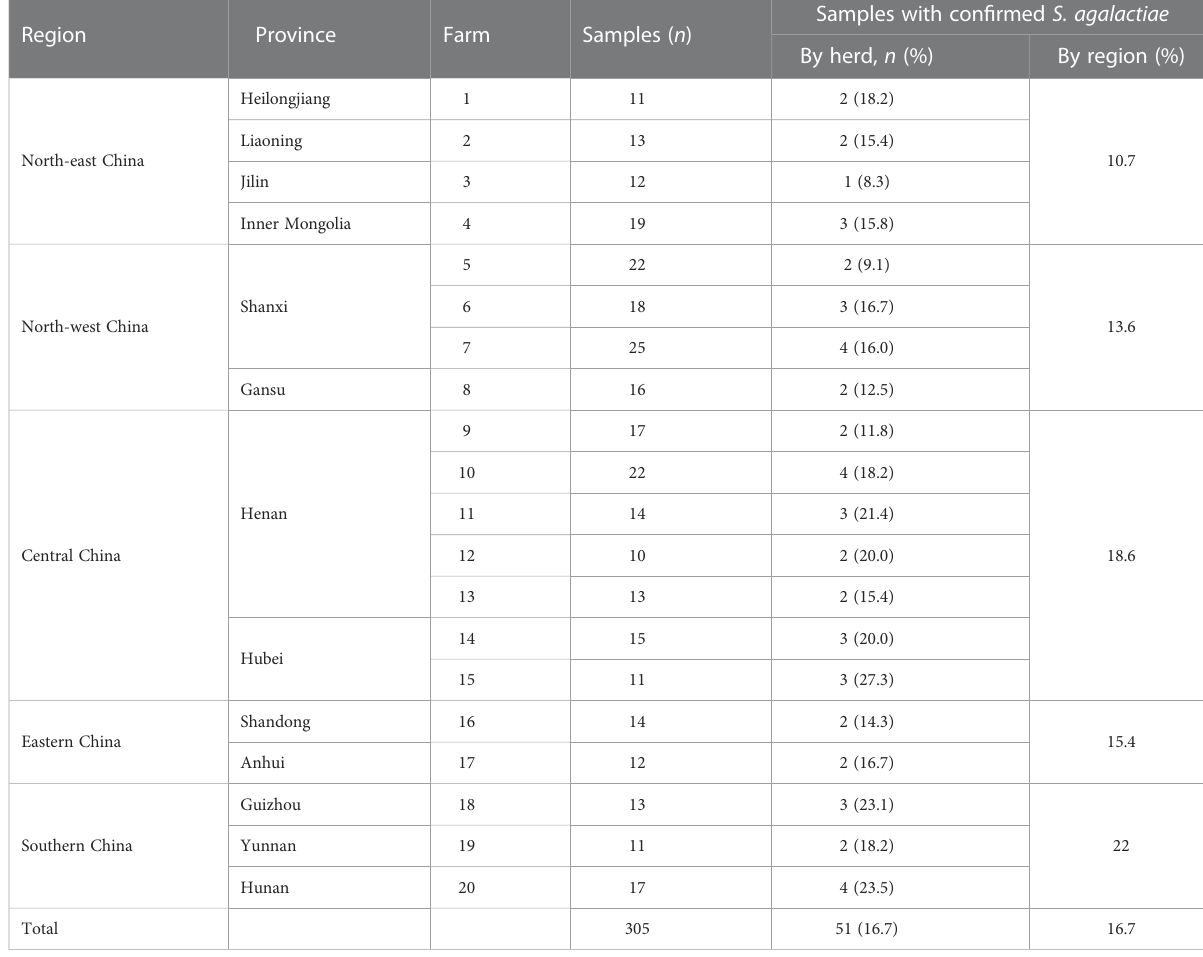
TABLE 1 Goat milk samples with clinical mastitis collected from backyard goat dairy farms in fi ve regions of China from 2015 to 2021. Region Province Farm Samples ( n )